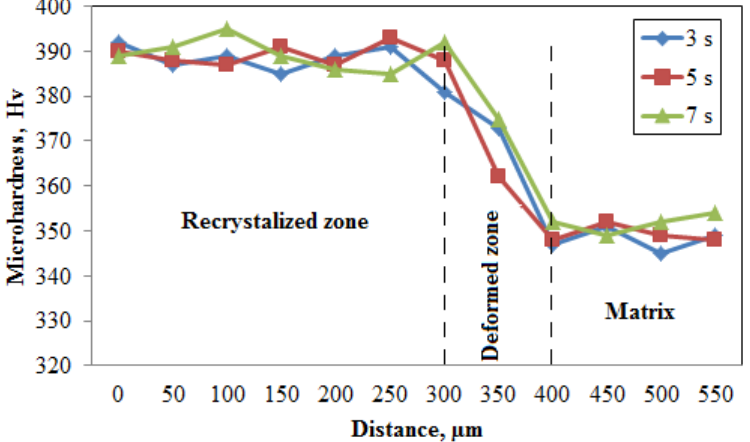
Figure 5. Microhardness profile of welded samples for 7 s under 200 MPa forging pressure and 140 MPa friction pressure from the weld center to a side.